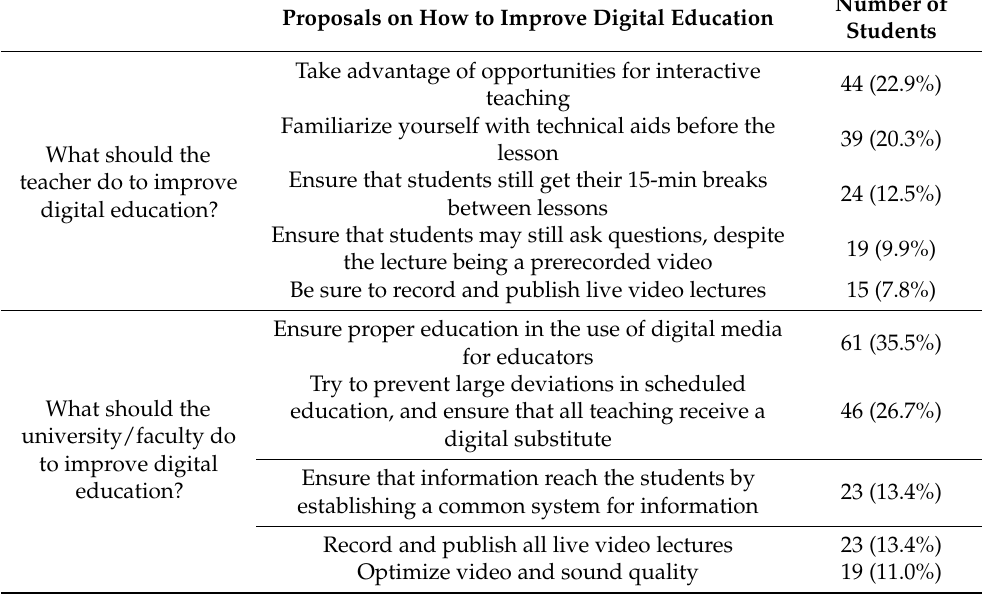
Table 4. Five most common answers when students were asked about how to improve digital education in the